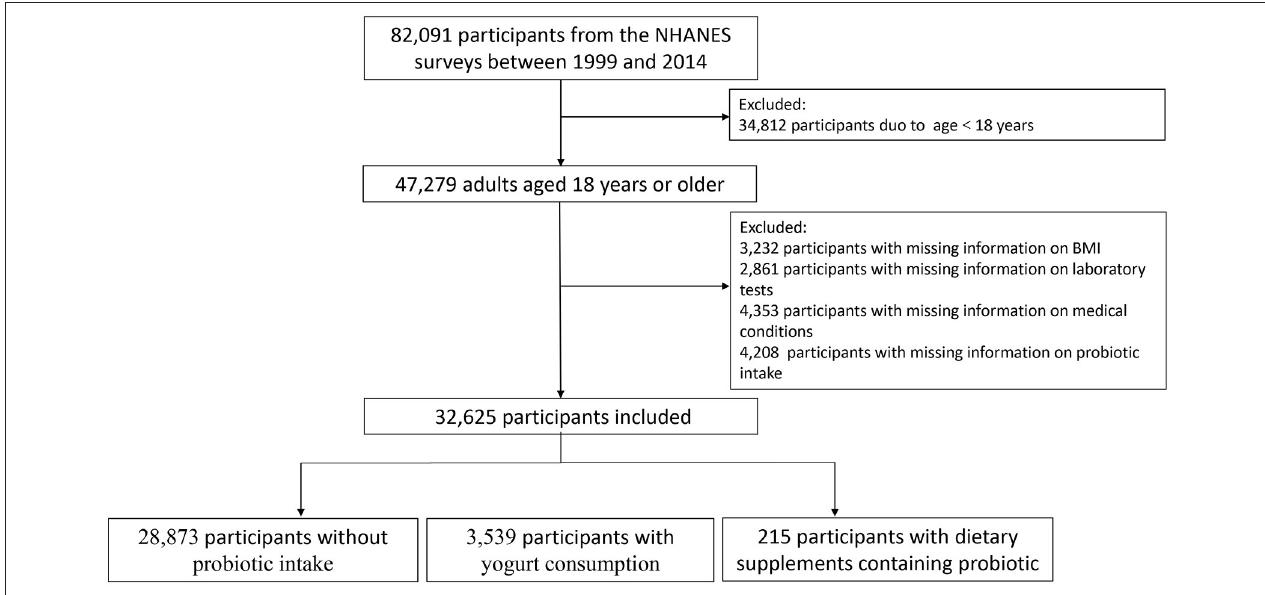
FIGURE 1 | Flowchart of patient